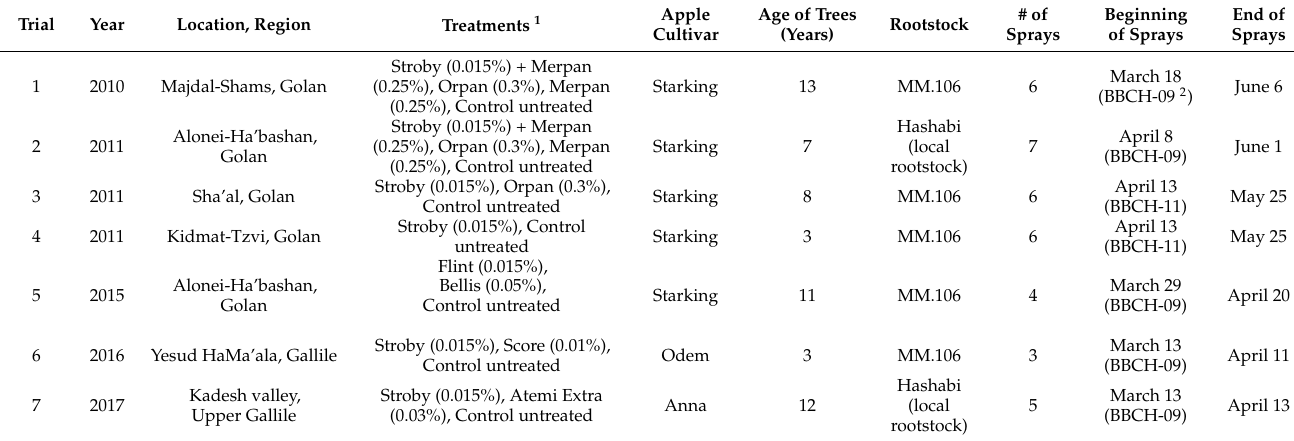
Table 2. Field trials conducted to assess the efficacy of strobilurin and triazole fungicides against V. inaequalis.